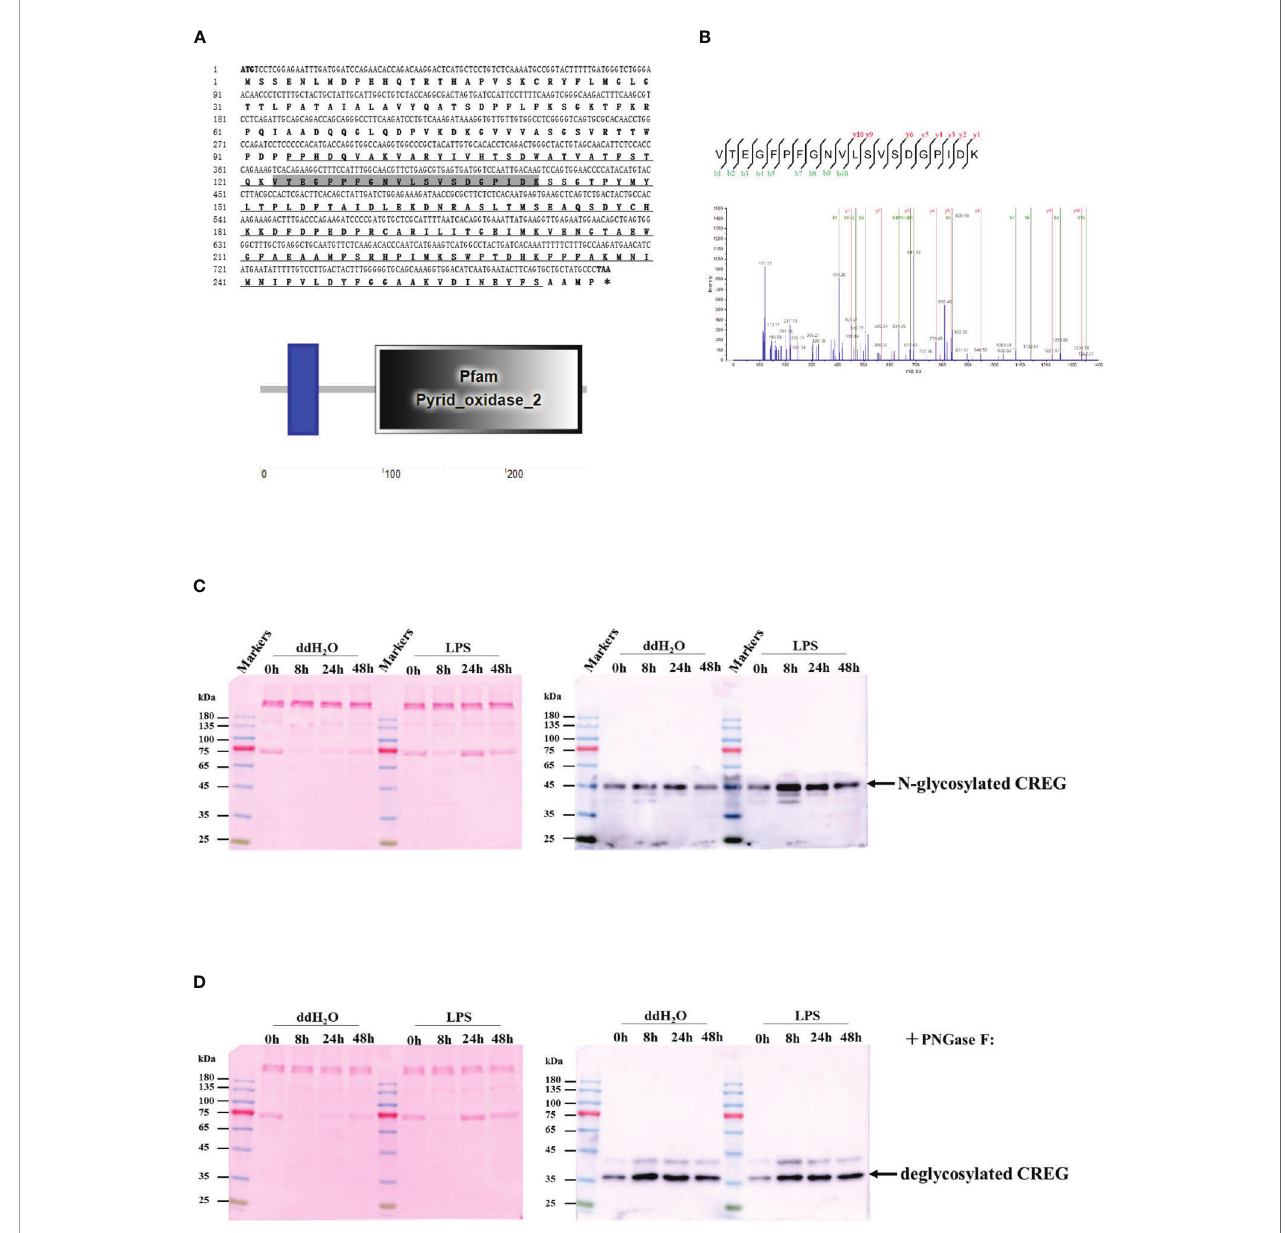
FIGURE 1 | Identi fi cation of shrimp cellular repressor of E1A-stimulated gene (CREG) protein as a lipopolysaccharide (LPS)-induced plasma glycoprotein. (A) The ORF of the amino acid sequence is shown with one-letter codes. The initiation codon (ATG) and the stop codon (TAA) are shaded. The structural domain prediction of shrimp CREG. (B) A peptide of CREG is identi fi ed with MS/MS spectrum. Shrimp plasma was collected at 0, 8, 24, and 48 h post-LPS injection, followed by ultracentrifugation to remove hemocyanin. After that, the supernatant was directly loaded for WB detection (C) before or (D) after deglycosylation. Right, the membrane was blotted with shrimp CREG-speci fi c antibody. Left, the membrane was stained with ponceau as a loading